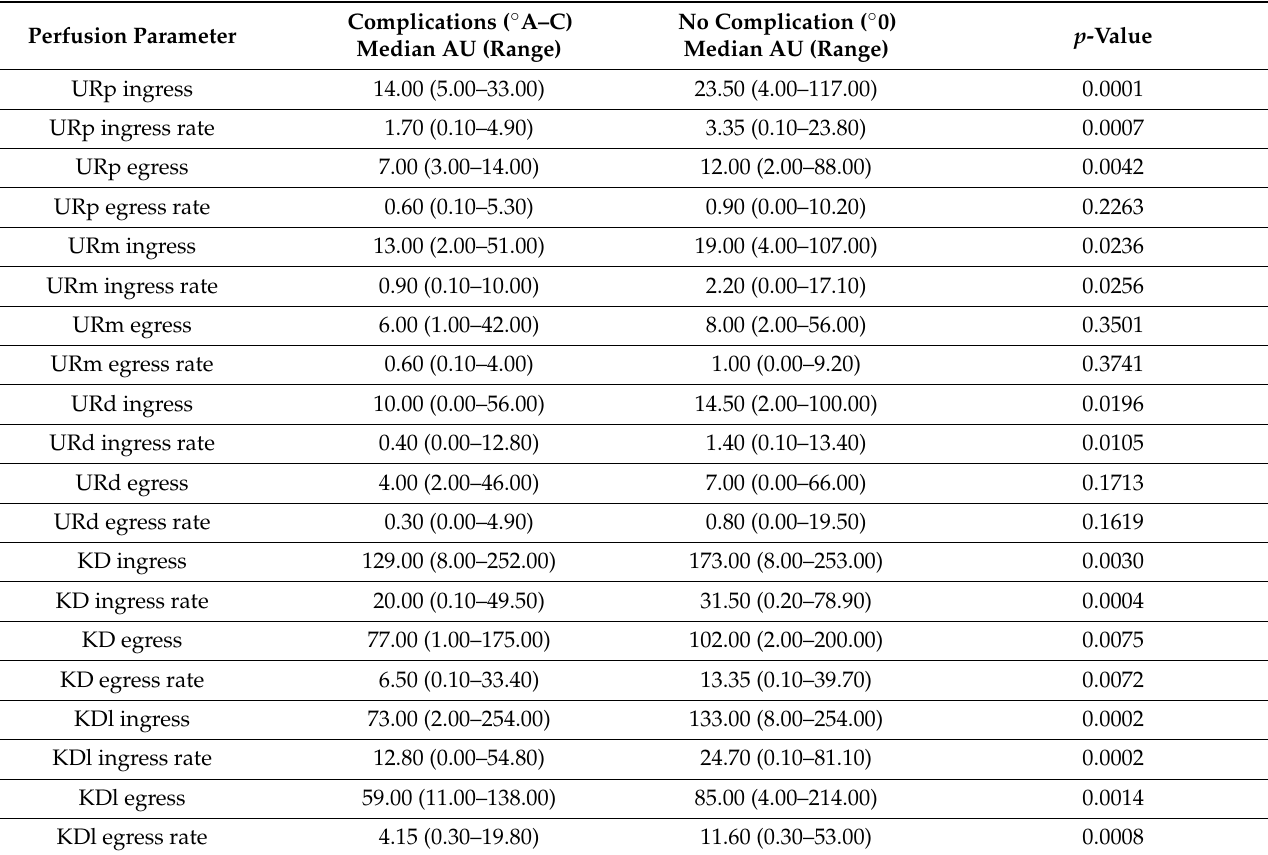
Table 4. Association between intraoperative ureteral and kidney perfusion assessment with ICG fluo- rescence angiography and the occurrence of postoperative ureterovesical anastomosis complications after kidney transplantation.